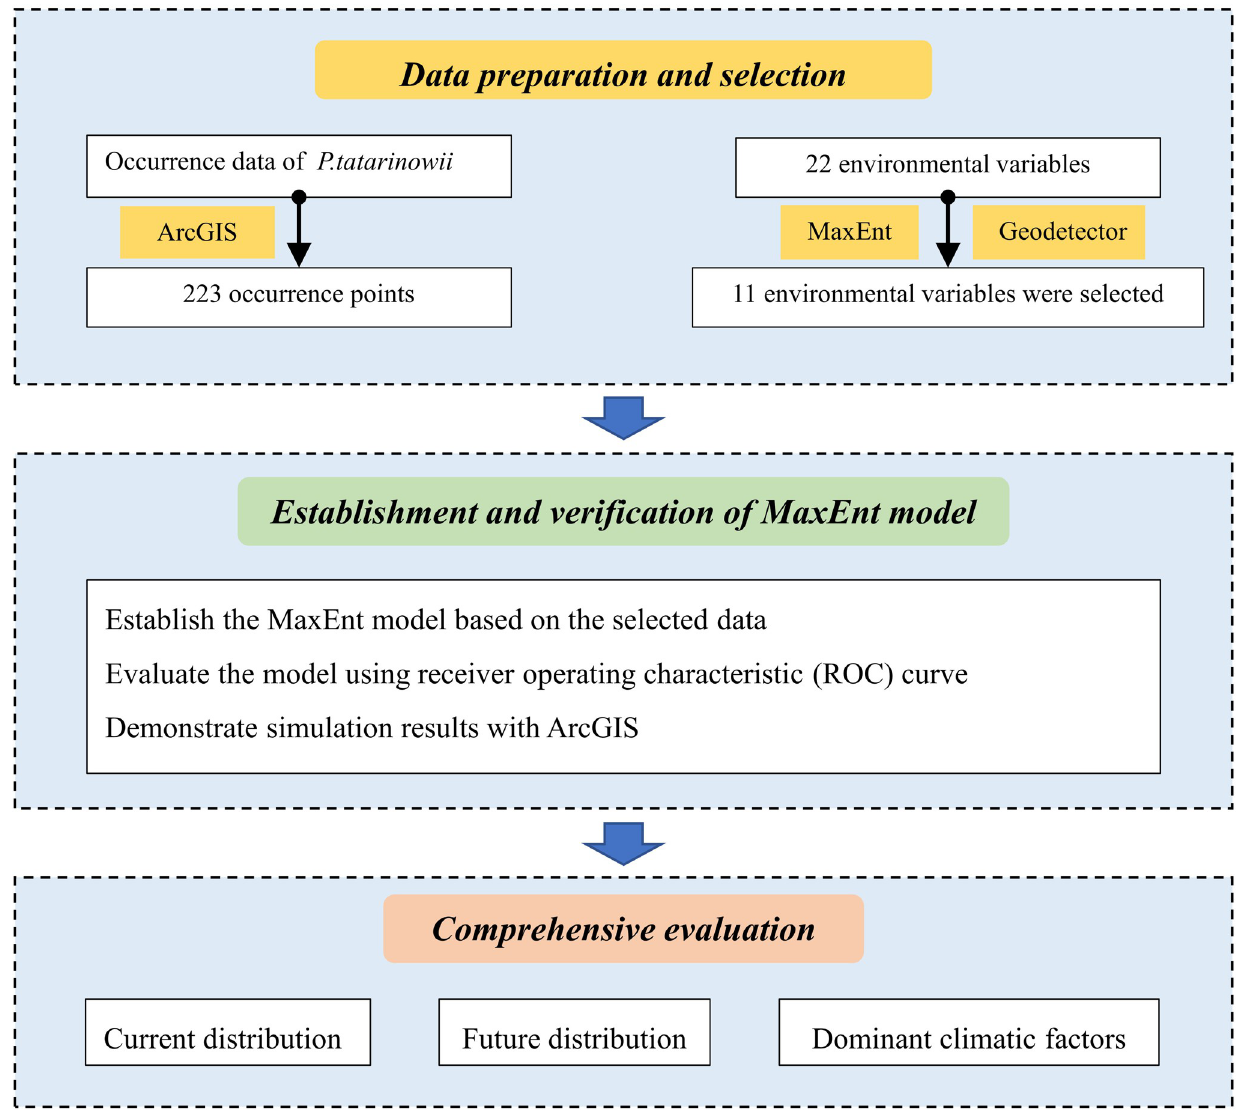
Fig 1. Flowchart displaying the steps of the present